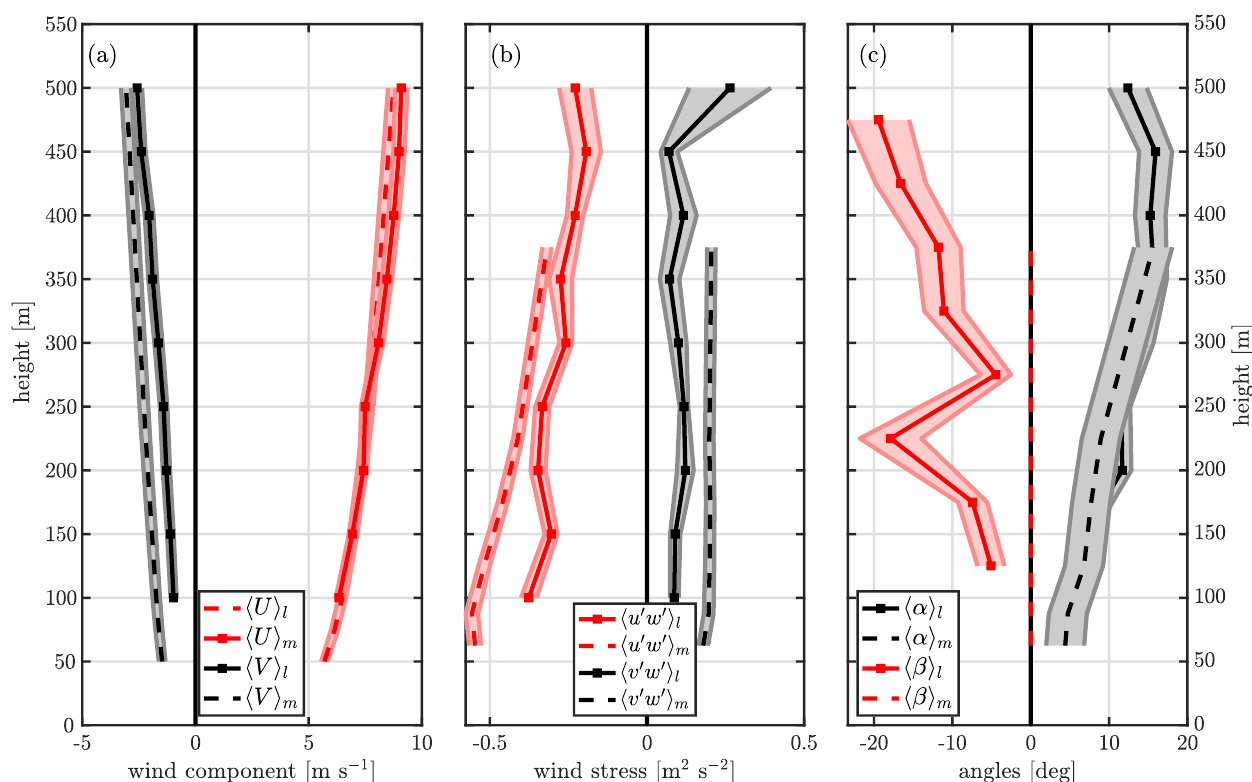
Figure 4. Mean vertical profiles of ( a ) horizontal wind components, ( b ) momentum fluxes and ( c ) wind-turning angles at Hamburg. The full lines are lidar observations ( l ) and dashed lines represent the NEWA-WRF output ( m ). All profiles are within 275° ± 45° and are computed from 616 30-min samples, where the shaded areas represent the standard errors of the